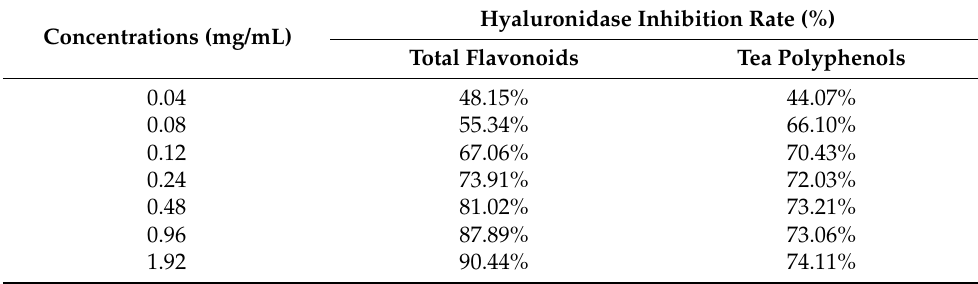
Table A3. The inhibition rate of allergic reactions with total flavonoids from perilla leaves.